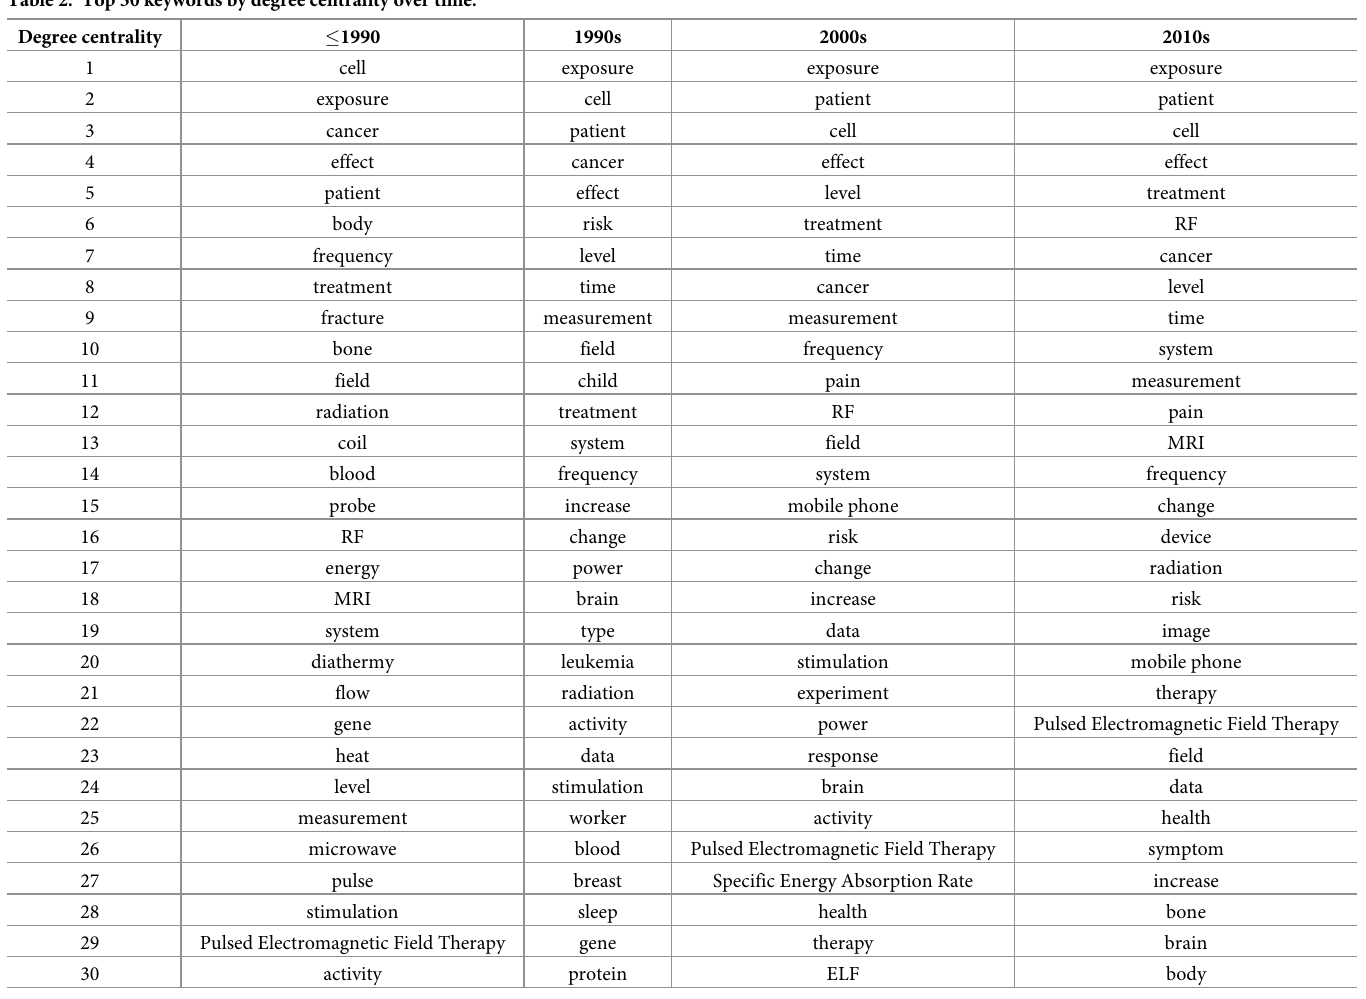
Table 2. Top 30 keywords by degree centrality over